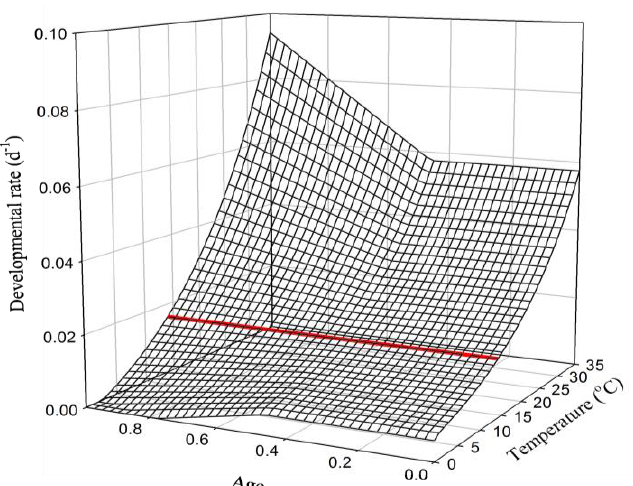
Figure 3. Age-( A ) and temperature ( T )-dependent developmental rates from Equation (8) (copied from Salis et al. [10]); the developmental rate at the threshold temperature (13.8 ◦ C, at which the age effect is zero) is displayed in the bold red line. r ( T , A ) = (cid:40) P ( T ) for A < 0.46 P ( T ) + ( A − 0.46 ) × S × ( P ( T ) − ρ ) for A ≥ 0.46 , where P ( T ) is the rate from Equation (5), S is a constant positive scaler (1.63) and ρ is from Equation (5) (=developmental rate at T = 13.8 ◦ C)